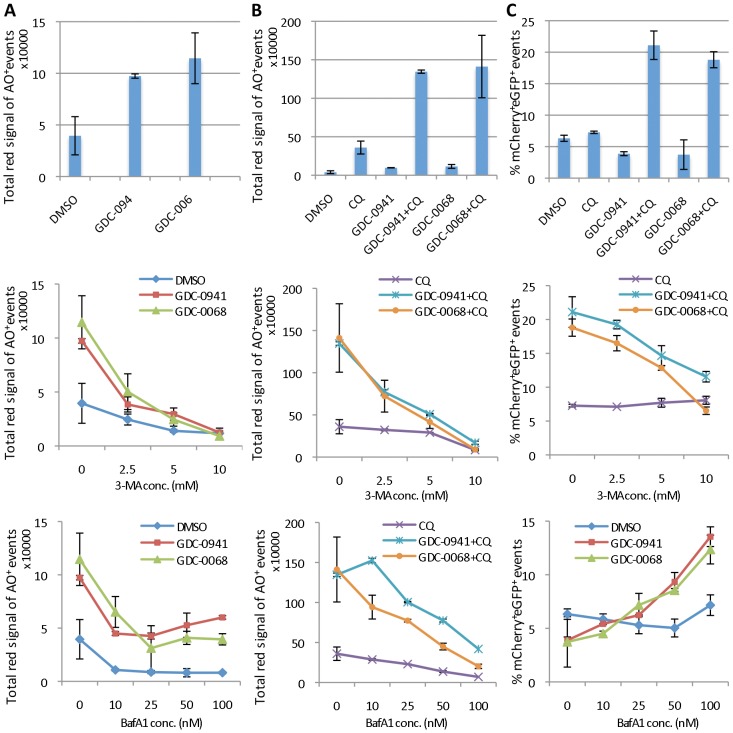
Inhibition of autophagy by 3-MA at an early stage and by BafA1 at a later stage can be distinguished by individual AV analysis with OFACS.Untransfected PC3 cells (A,B) or PC3 cells expressing mCherry-eGFP-LC3B (C) treated with 1 µM GDC-0941 or 5 µM GDC-0068 +/− 10 µM CQ for 24 hours with the addition of: nothing (upper panels), 0–10 mM 3-MA (middle panels) or 0–100 nM Bafilomycin A1 (BafA1; bottom panels). AVs were analyzed by OFACS after staining with AO (A,B) or unstained (C). Y axes represent the total “red” channel intensity of AO+ organelles normalized to cell number (A,B) or the percentage of mCherry+eGFP+ events of the total subcellular events (C). Note the different scales of the y-axes in (A) vs. (B). Error bars represent standard deviations (SD), n = 3.